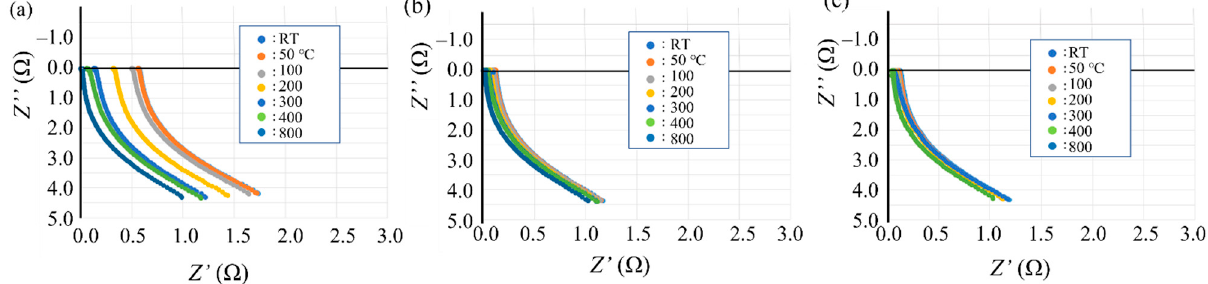
Figure 12. Nyquist diagrams of ball-milled Inconel 718 PA powder measured by AC impedance spectroscopy at room temperature (23 °C) and at 50, 100, 200, 300, 400, and 800 °C: ( a ) Ball milling time of 10 min; ( b ) Ball milling time of 30 min; ( c ) Ball milling time of 60 min.